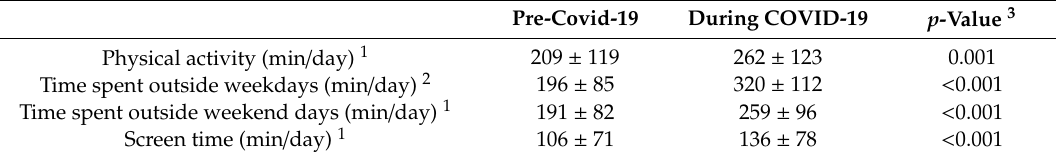
Mean and standard deviation for parent reported physical activity, time spent outside, and screen time pre-COVID-19 and during